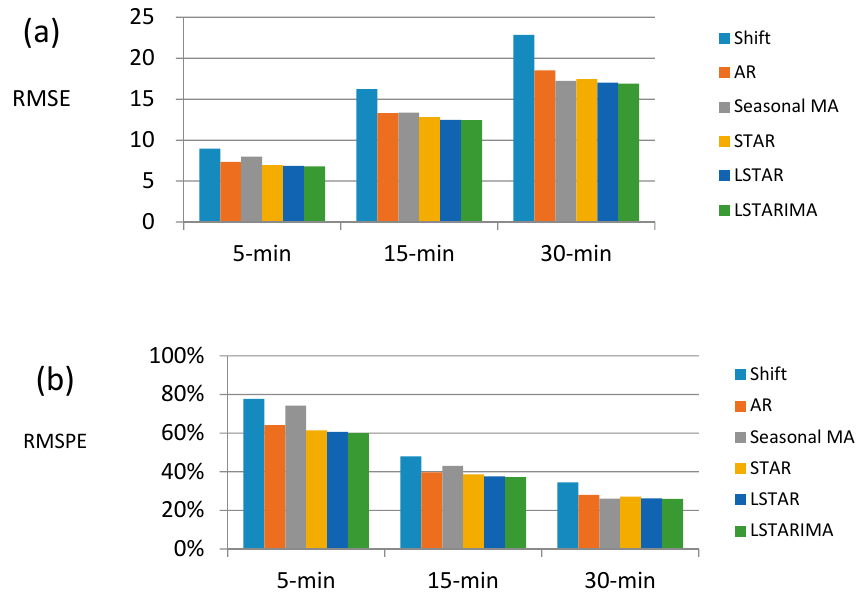
Figure 5. Average prediction accuracy comparison of different models: ( a ) Root Mean Square Error (RMSE); and ( b ) Root Mean Square Percentage Error (RMSPE).